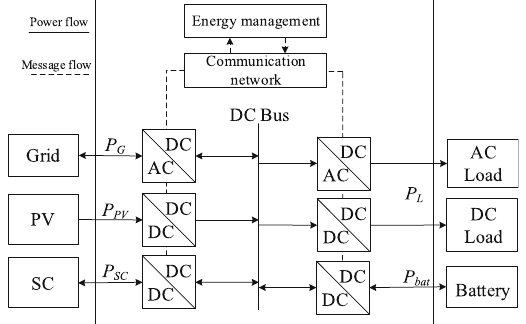
Fig. 3 The principle of the improved variable step size disturbance observation method